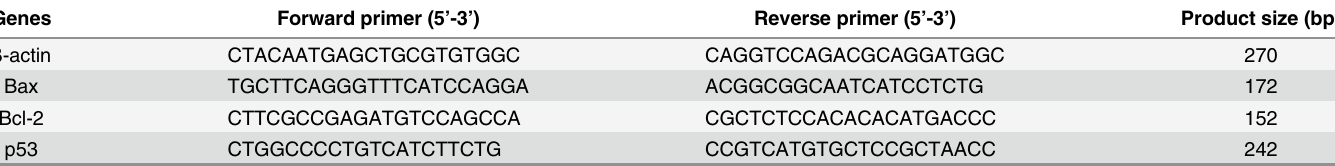
Table 1. Primers Used for